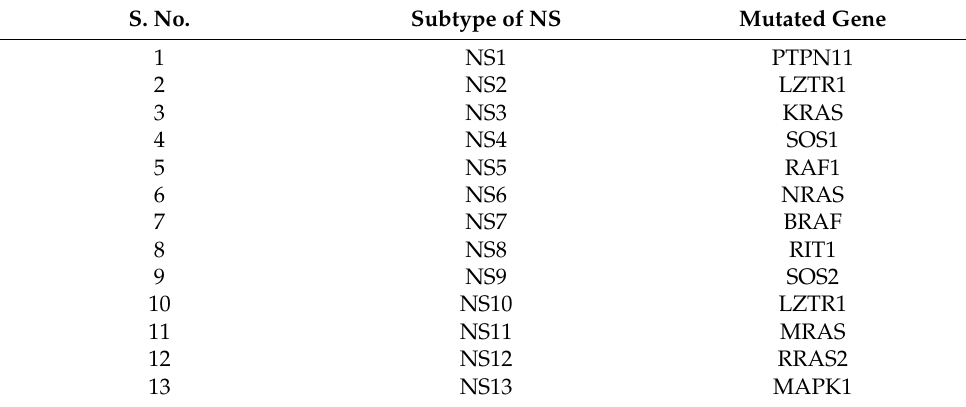
Table 2. Genetic heterogeneity in Noonan syndrome with the name of the mutated gene in each subtype. The table is compiled using data from OMIM- Online Mendelian Inheritance in Man ® - https://www.omim.org/ (Online Mendelian Inheritance in Man, OMIM ® . McKusick-Nathans Institute of Genetic Medicine, Johns Hopkins University (Baltimore, MD), World Wide Web URL: https://omim.org/) (accessed on 30 May 2021). S. No. Subtype of NS Mutated Gene NS1